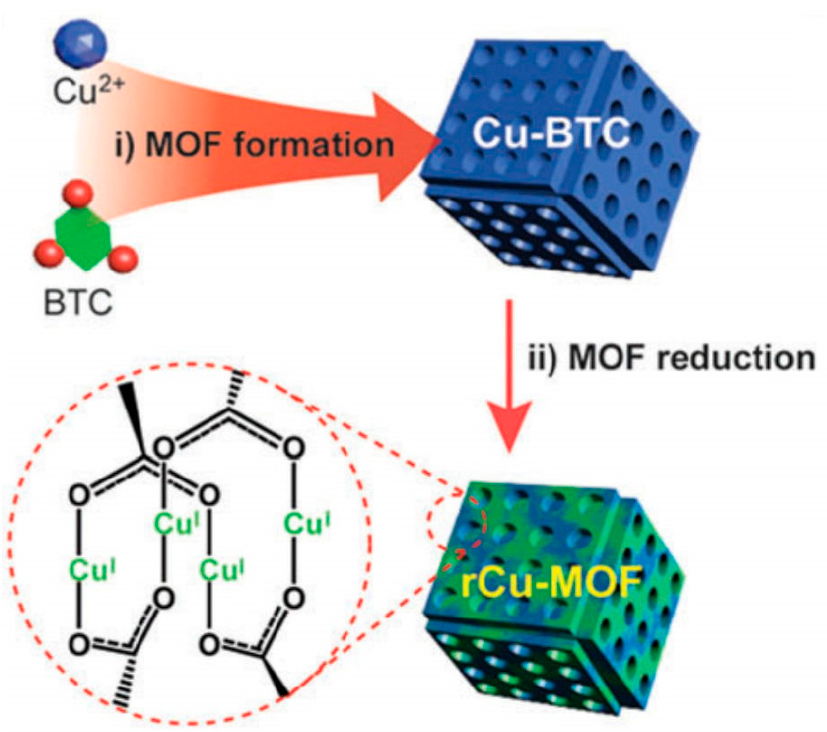
Figure 20. A simplified depiction of the steps required to make a reduced copper metal–organic framework (rCu-MOF). (i) Benzene 1,3,5-tricarboxylate (BTC) undergoes a coordination reaction with Cu 2+. and (ii) a hydroquinone-induced Cu-BTC reduction at 150 ◦ C. Reproduced from [120] with permission from RSC, copyright year: